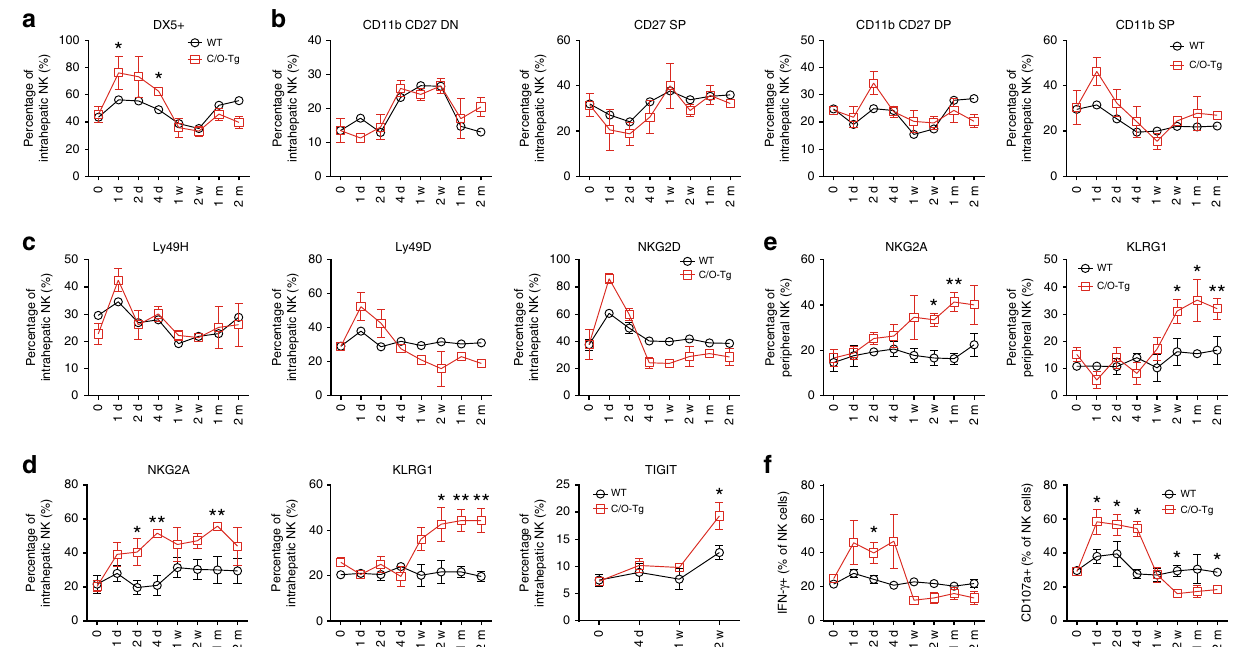
Fig. 2 Impaired hepatic NK cell response during HCV persistent infection in C/O Tg mice. Mice were treated as in Fig. 1a. FACS analyses of intrahepatic NK cells for expression of a DX5, b CD11b, and CD27, c activation receptors, including Ly49D, Ly49H, and NKG2D, and d inhibitory receptors, including NKG2A, KLRG1, and TIGIT. e FACS analyses of peripheral NK cells for expression of NKG2A and KLRG1. f NK function assays were carried out at indicated time of HCV infection by Yac-1 cell stimulation. CD107a and IFN- γ expression were FACS analyzed. Data were mean ± SD, ANOVA test. * P < 0.05; ** P < 0.01. Source data are provided as a Source Data fi